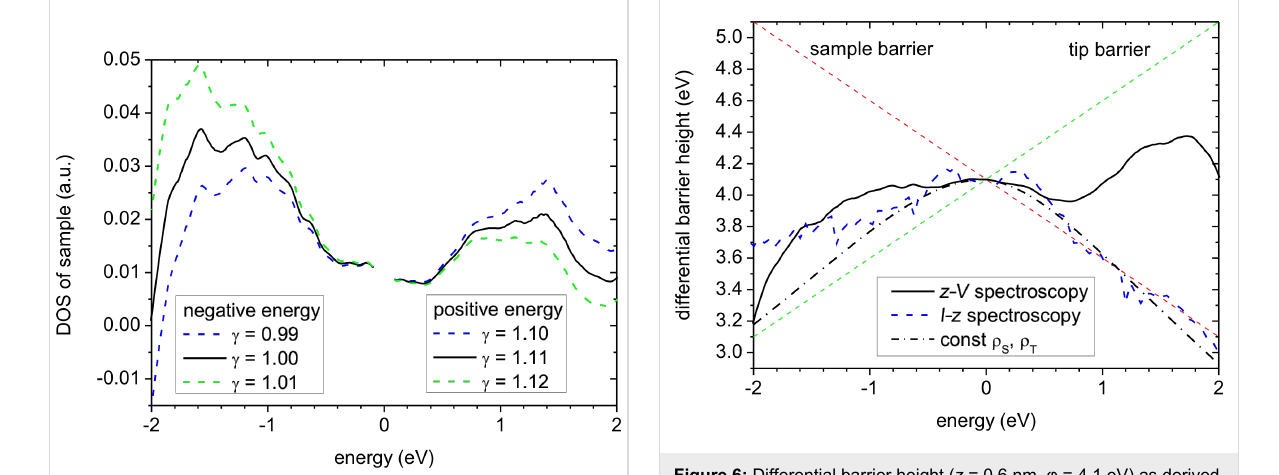
Figure 6: Differential barrier height ( z = 0.6 nm, φ = 4.1 eV) as derived from the deconvolved DOS (Figure 4, solid curves) according to the WKB approximation, and as obtained from an independent ∂ V I – z measurement with the same tip on the same sample at the same pos- ition (dashed blue). The black dash-dotted curve is the calculated DBH for constant DOS using the same TPF as for the other data, i.e., β = 2, γ = 1.11 for positive bias and γ = 1.0 for negative bias. The sample and tip barriers indicate the barriers experienced by electrons at the Fermi level of the tip and of the sample, respectively, according to the one- dimensional WKB